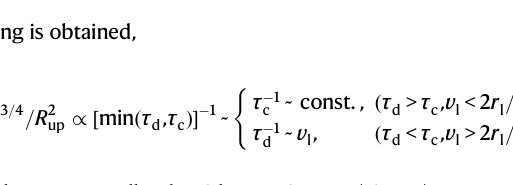
Fig.4|Bubbledancingguidedbythetranslationoflaserbeam.a Sketchforthe bubble following after the laser beam. b Images of bubble moving trajectory with translationspeedof1,3,and5mm/s. c Phasediagramofbubbledancingdependent